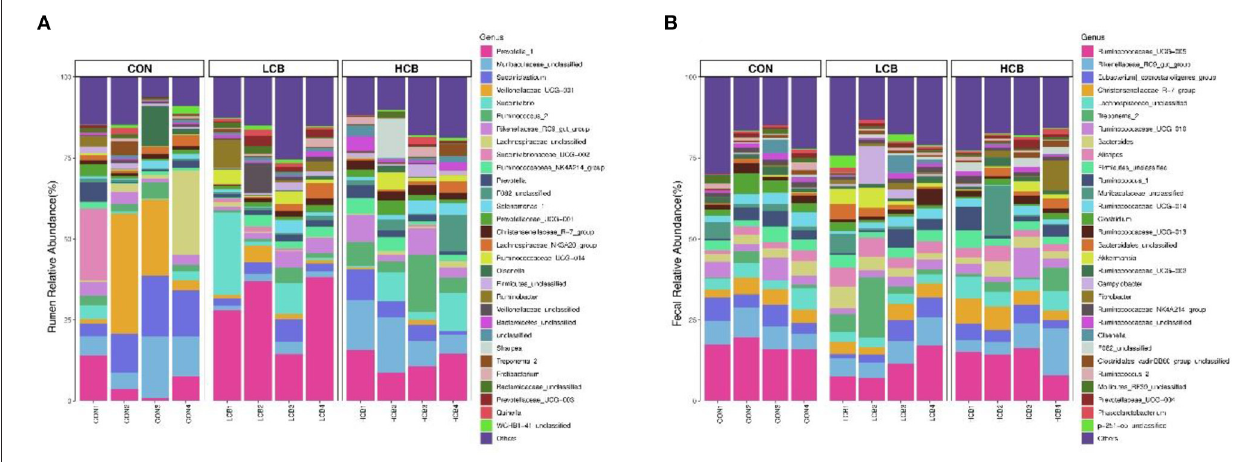
FIGURE 4 | Stacked bar graph displays a comparison of microbial relative abundance (%) at genus level among main effects of treatments in rumen (A) and fecal (B) of fattening goats. The label CON denotes without prebiotics, the label LCB denotes low-dose C. butyricum, and the label HCB denotes high-dose C. butyricum for each sample. The letters (1,2,3 and 4) denote replicate samples. CON: 0 CFU C. butyricum per kilogram feed, LCB: 2.0 × 10 8 CFU C. butyricum per kilogram feed, HCB: 1.0 × 10 9 CFU C. butyricum per kilogram